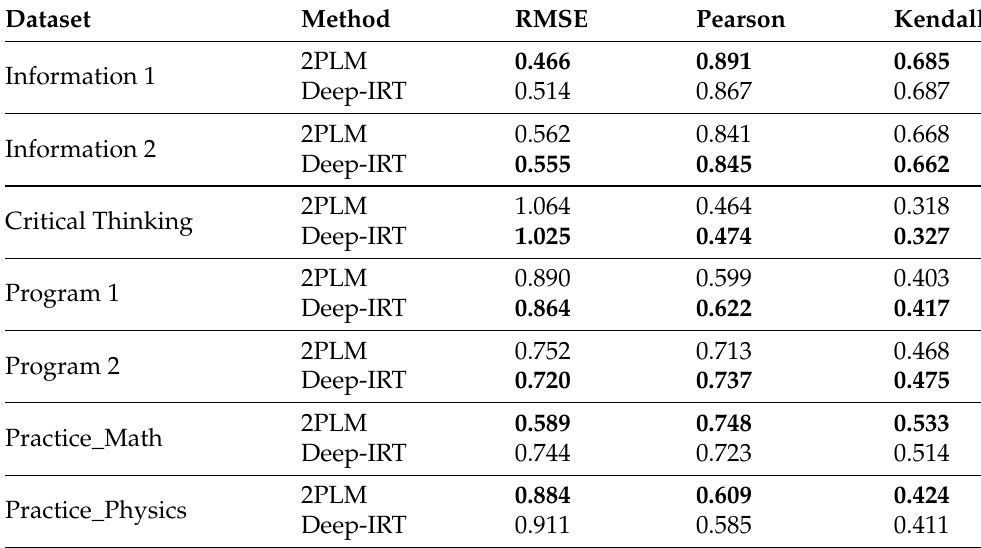
Table 4. Reliability of ability parameter